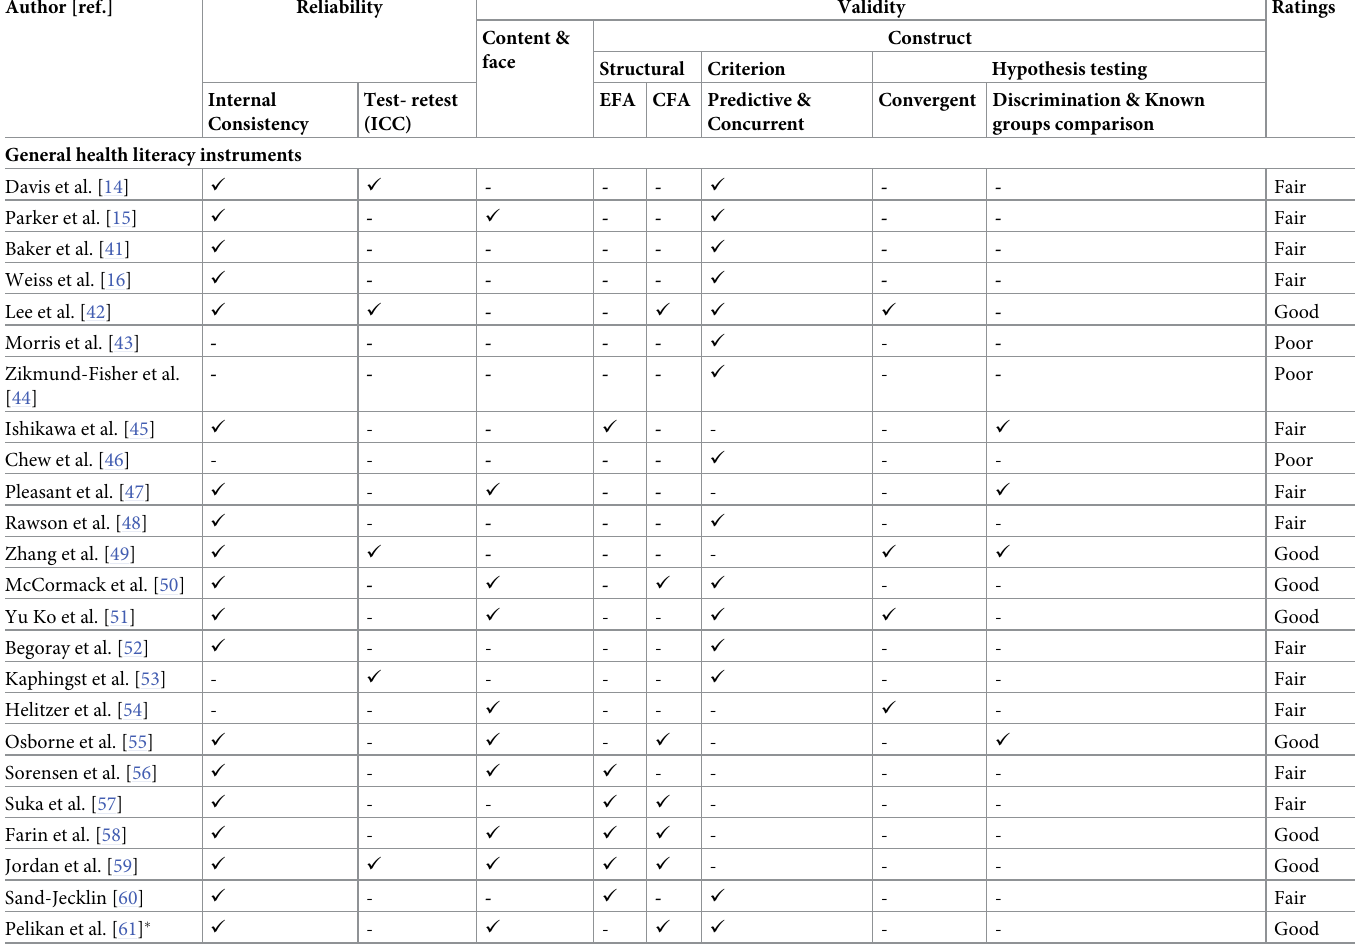
Table 8. The results for quality assessment of existing health literacy instruments